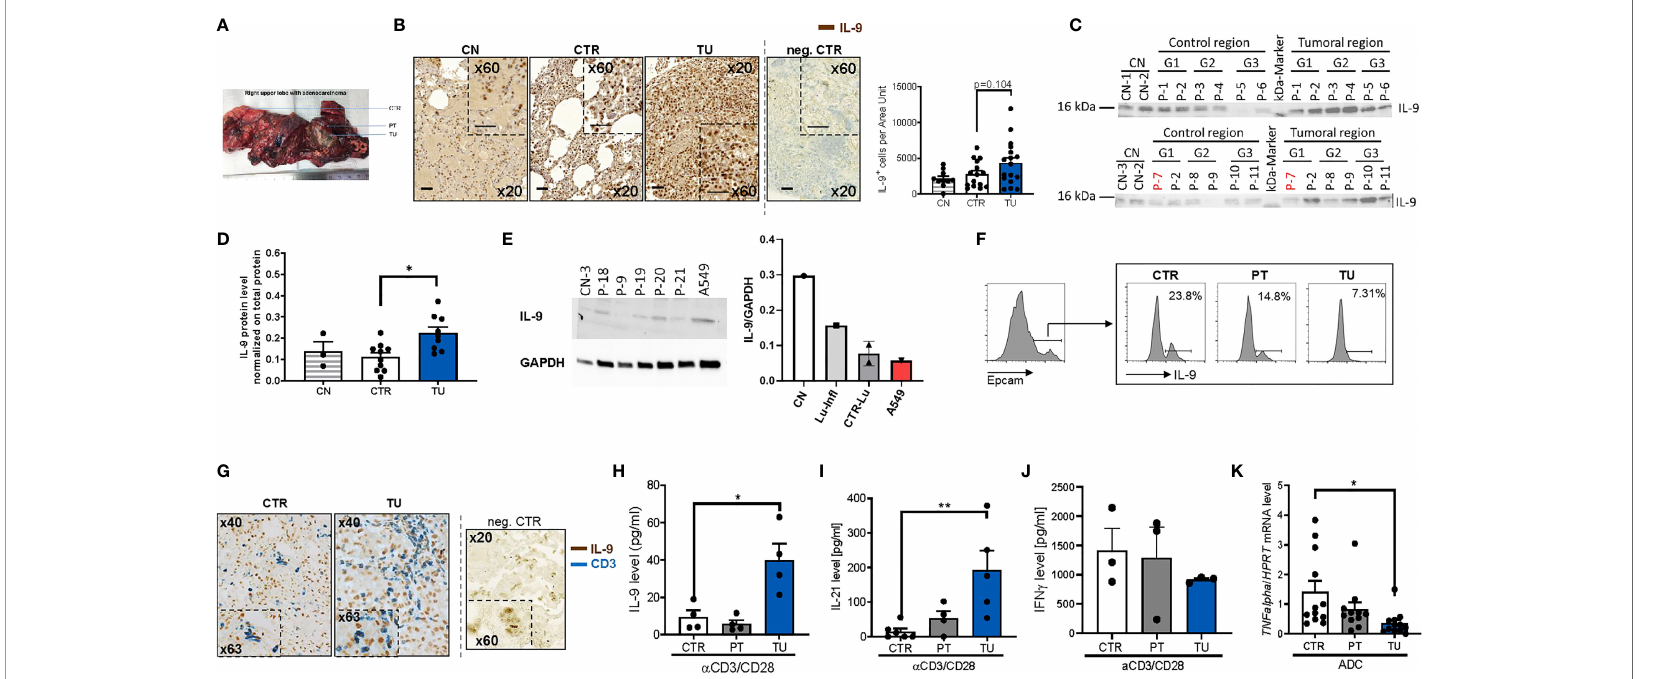
FIGURE 1 | Increased IL-9 production by T cells in the tumoral lung region of NSCLC patients. (A) Representative photographic image of the resected lung of one NSCLC patient as a showcase of de fi ned regions implemented for our human study cohort. Lung tissue samples were dissected from the tumoral area (TU), the peri-tumoral area (PT) surrounding the tumor and from the control area (CTR) consisting out of healthy lung tissue. (B) IL-9 immunohistochemistry (IHC) on paraf fi n-embedded tissue arrays obtained from the lung of tumor-free control patients (CN) or the CTR and TU lung regions of non-small cell lung cancer (NSCLC) patients (nCN=10; nCTR=15; nTU=17) (scale bar=50 µm). (C, D) Proteins were isolated from lung tissue samples of control patients (CN), the CTR and the TU of NSCLC ADC patients (classi fi ed by grading of tumor cell differentiation (G1, G2 and G3) and Western blot was performed. Detected protein levels of IL-9 were normalized on total protein of the samples (CN: n=3, CTR: n=10, TU:n=10). (E) Proteins were isolated from tissue samples of control patients that underwent surgery due to disease unrelated to tumor and from cells of the adenocarcinoma cell line A549. Analysed data are shown as mean ± SEM (nCN=1; nLu-In fl (Lung in fl ammation)=1; CTR-Lu=CTR, n=2; nA549 = 1) or single values. (F) Flow cytometry analysis of IL-9+ cells (shown in percentage) gated on Epcam+ cells of cells isolated from the CTR, the PT and the TU of a NSCLC patient. (G) Double IHC for IL-9 (brown) and CD3 (blue) on lung tissue obtained from the CTR and TU regions of an adenocarcinoma ( ADC) patient (scale bar=50 µm ). (H) ELISA analysis of IL-9 levels (pg/ml), (I) IL-21 levels (pg/ml), (J) IFN g (pg/ml) in supernatants obtained from total cells isolated from the control (CTR), peri-tumoral (PT) and tumoral (TU) region of adenocarcinoma (ADC) patients and cultured with anti( a )-CD3/CD28 antibodies for 24h (IL-21: nCTR=6, nPT=4, nTU=5; IFN g : nCTR=3; nPT=3; nTU=3). (K) TNF-alpha mRNA level from total lung cells was normalized on HPRT mRNA level (nCTR=12, nPT=11, nTU=12). N values are given per group. Bar charts indicate mean values +/- s.e.m. using student´s two-tailed t-test *P,0.05; **P,0.01;